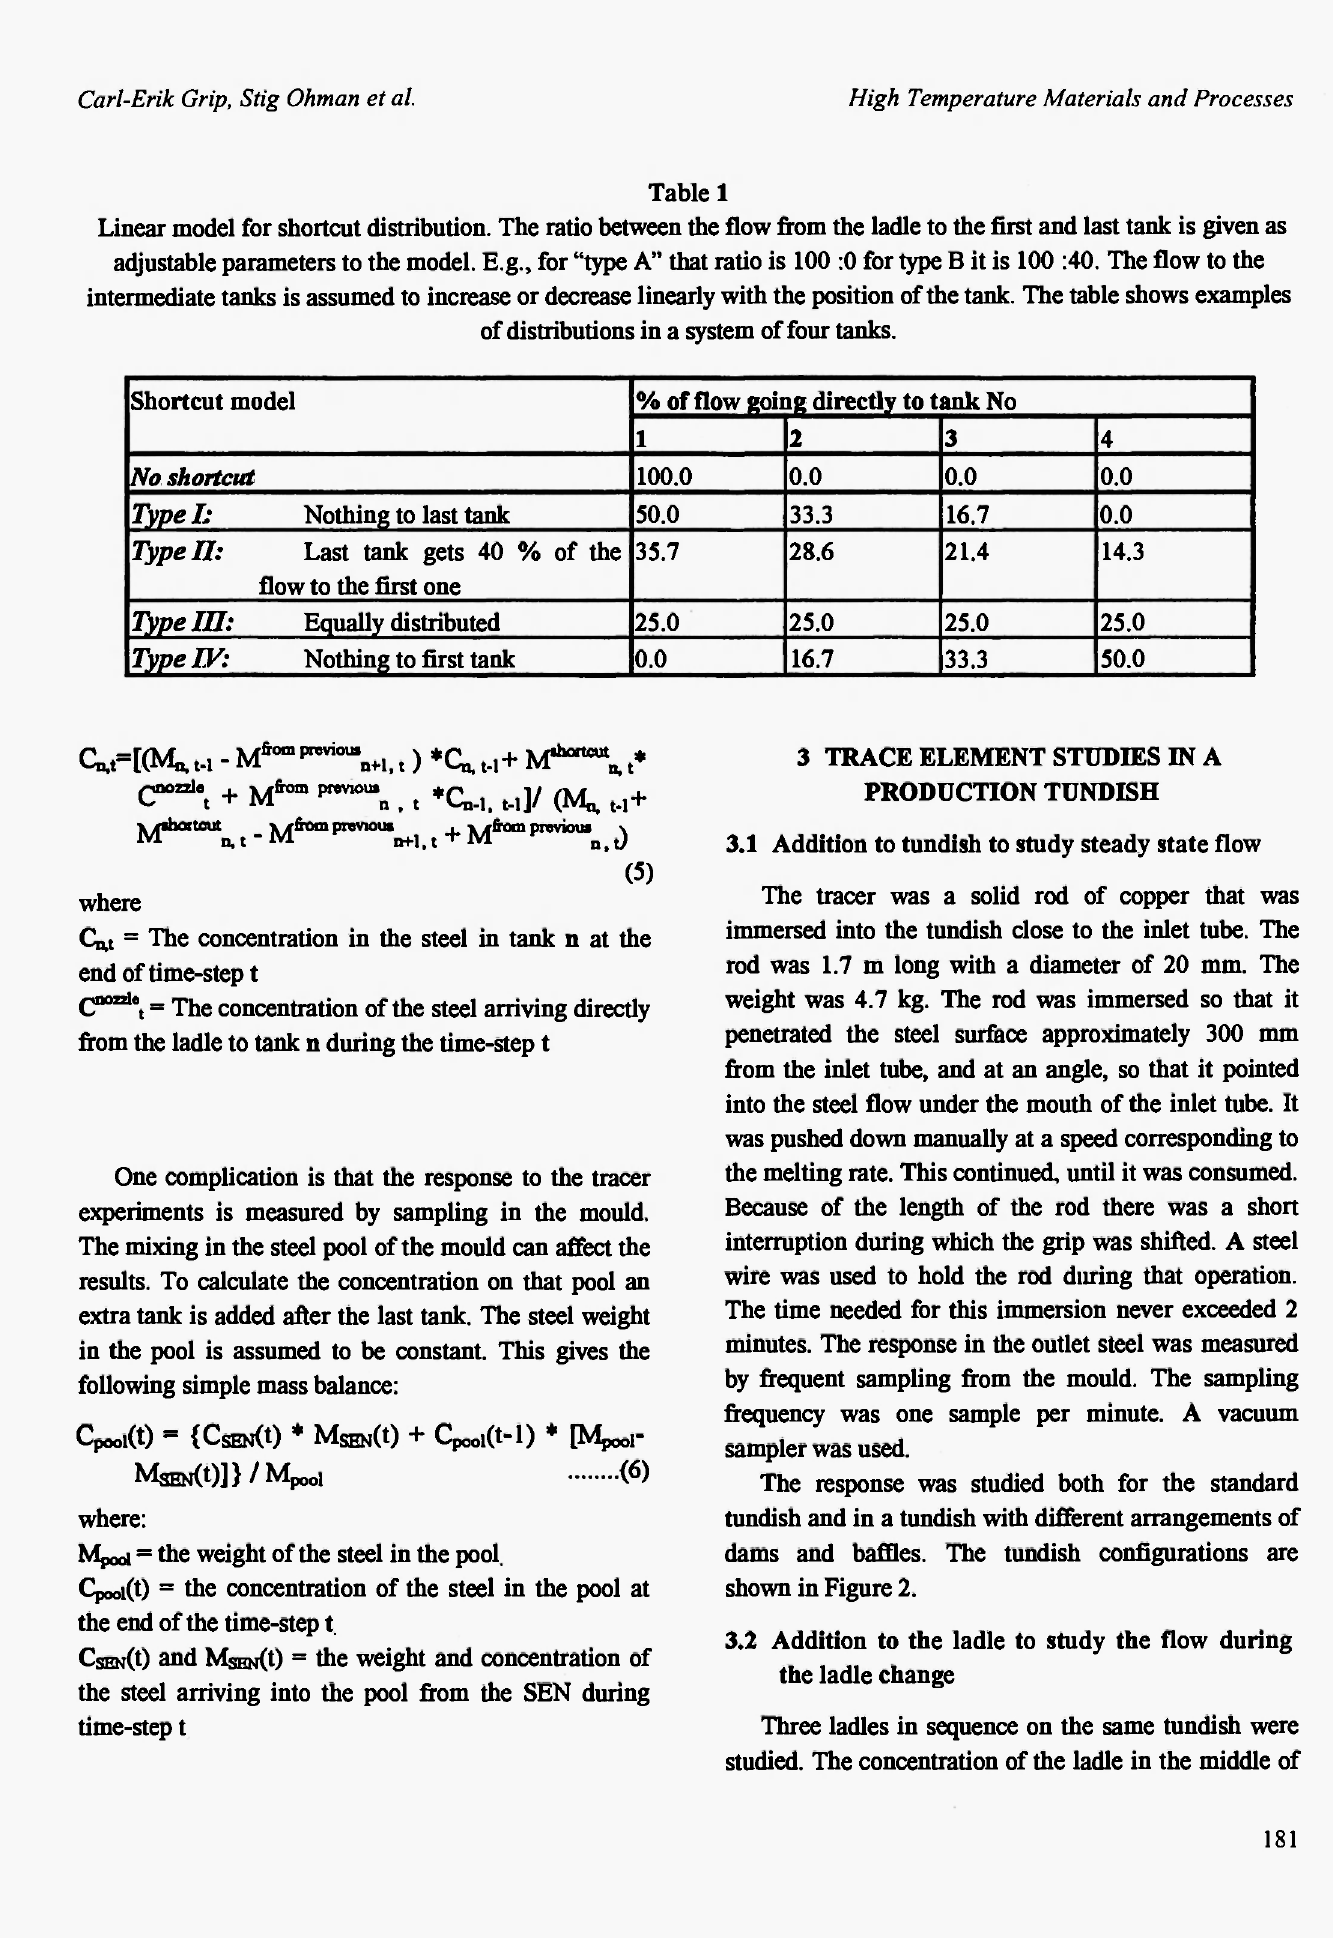
Linear model for shortcut distribution. The ratio between the flow from the ladle to the first and last tank is given as adjustable parameters to the model. E.g., for "type A" that ratio is 100 :0 for type Β it is 100 :40. The flow to the intermediate tanks is assumed to increase or decrease linearly with the position of the tank. The table shows examples of distributions in a system of four